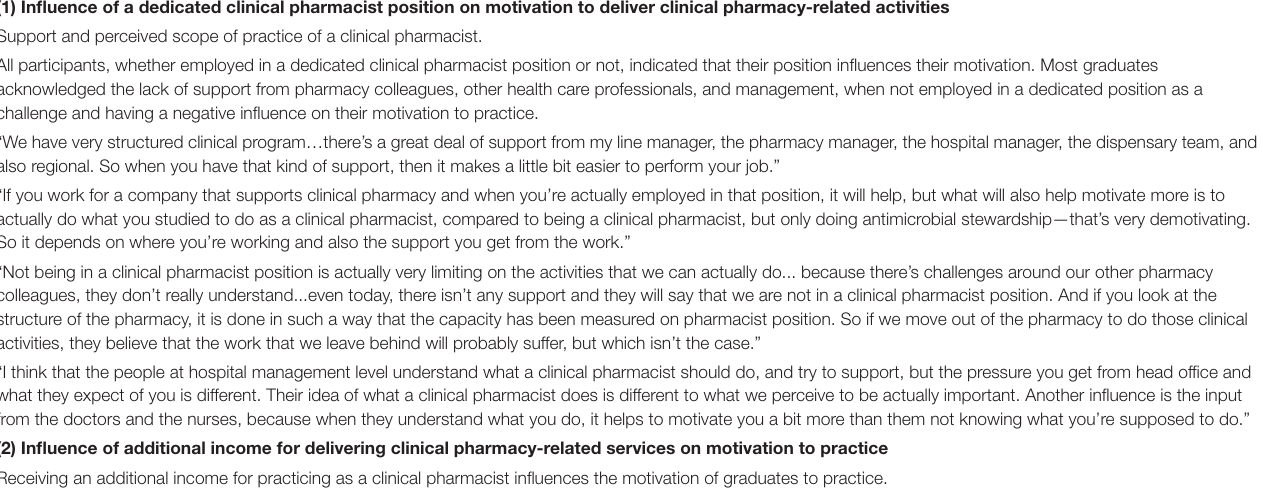
TABLE 3 | Interview results [including quotes of the participants ( n = 6) of the semi-structured interviews]. (1) Influence of a dedicated clinical pharmacist position on motivation to deliver clinical pharmacy-related activities Support and perceived scope of practice of a clinical